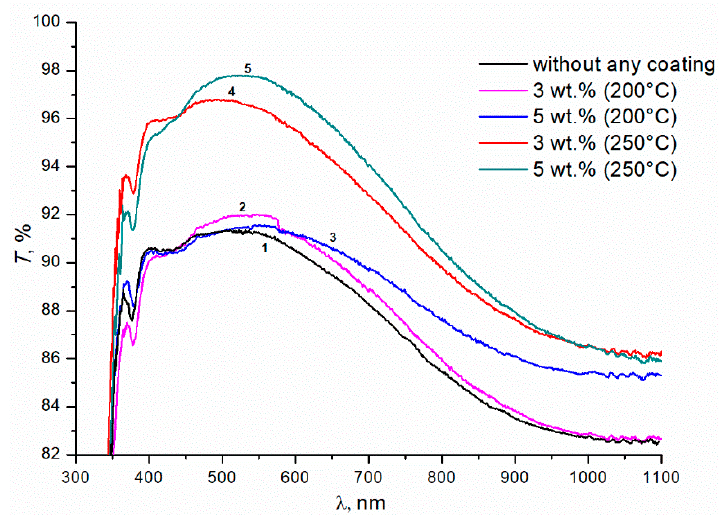
Figure 1. Transmittance of silicate glass without any coating and with the coatings obtained from sols of silicon dioxide with the addition of TBAB of various concentrations (wt.%). Annealing temperatures of gel at 200 °C and 250 °C; duration of annealing is 1 h.